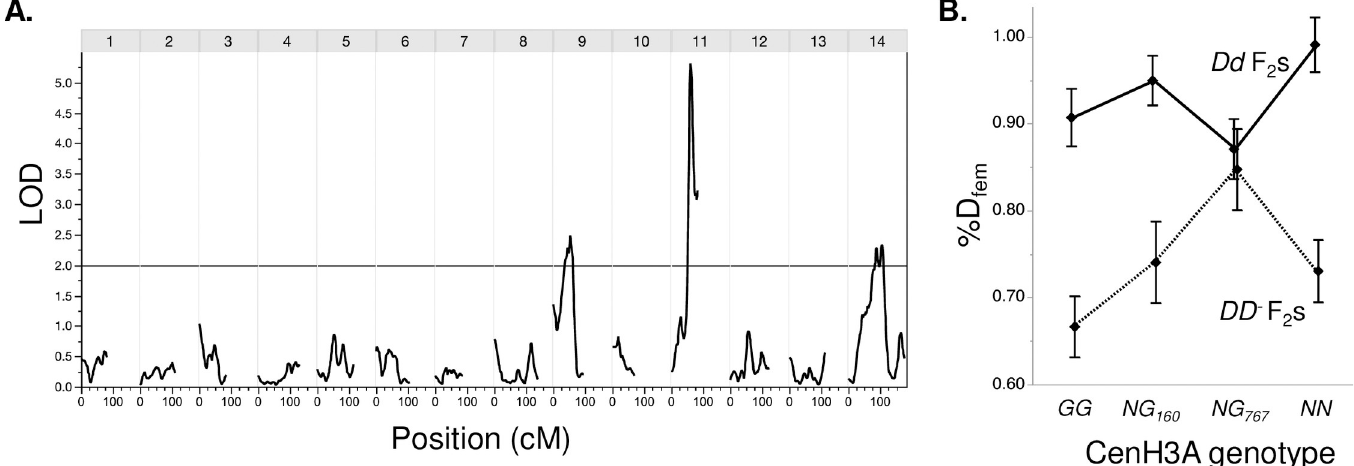
Fig 3. The strength of conspecific vs. heterospecific drive depends on MDL11 genotype, as well as unlinked modifiers. (A) A quantitative trait locus (QTL) scan of transmission ratio distortion in F 3 progeny of F 2 hybrids reveals unlinked modifier QTLs on Chromosome 9 and 14, in addition to the primary effect of MDL11 genotype. LOD score trace is smoothed, with a window size of four markers. B Genotype at CenH3A, which is centered under the Chromosome 14 modifier QTL, significantly influences D transmission in hybrids. Means ± 1 SE are shown for the eight F 2 genotypic classes: DD - and Dd at MDL11and GG (IM160/IM767 M . guttatus ), NG (heterozygote with M . guttatus allele from IM160 parent), NG 767 (heterozygote with M . guttatus allele from IM767 parent), and NN (M. nasutus ) at CenH3A. Total n =